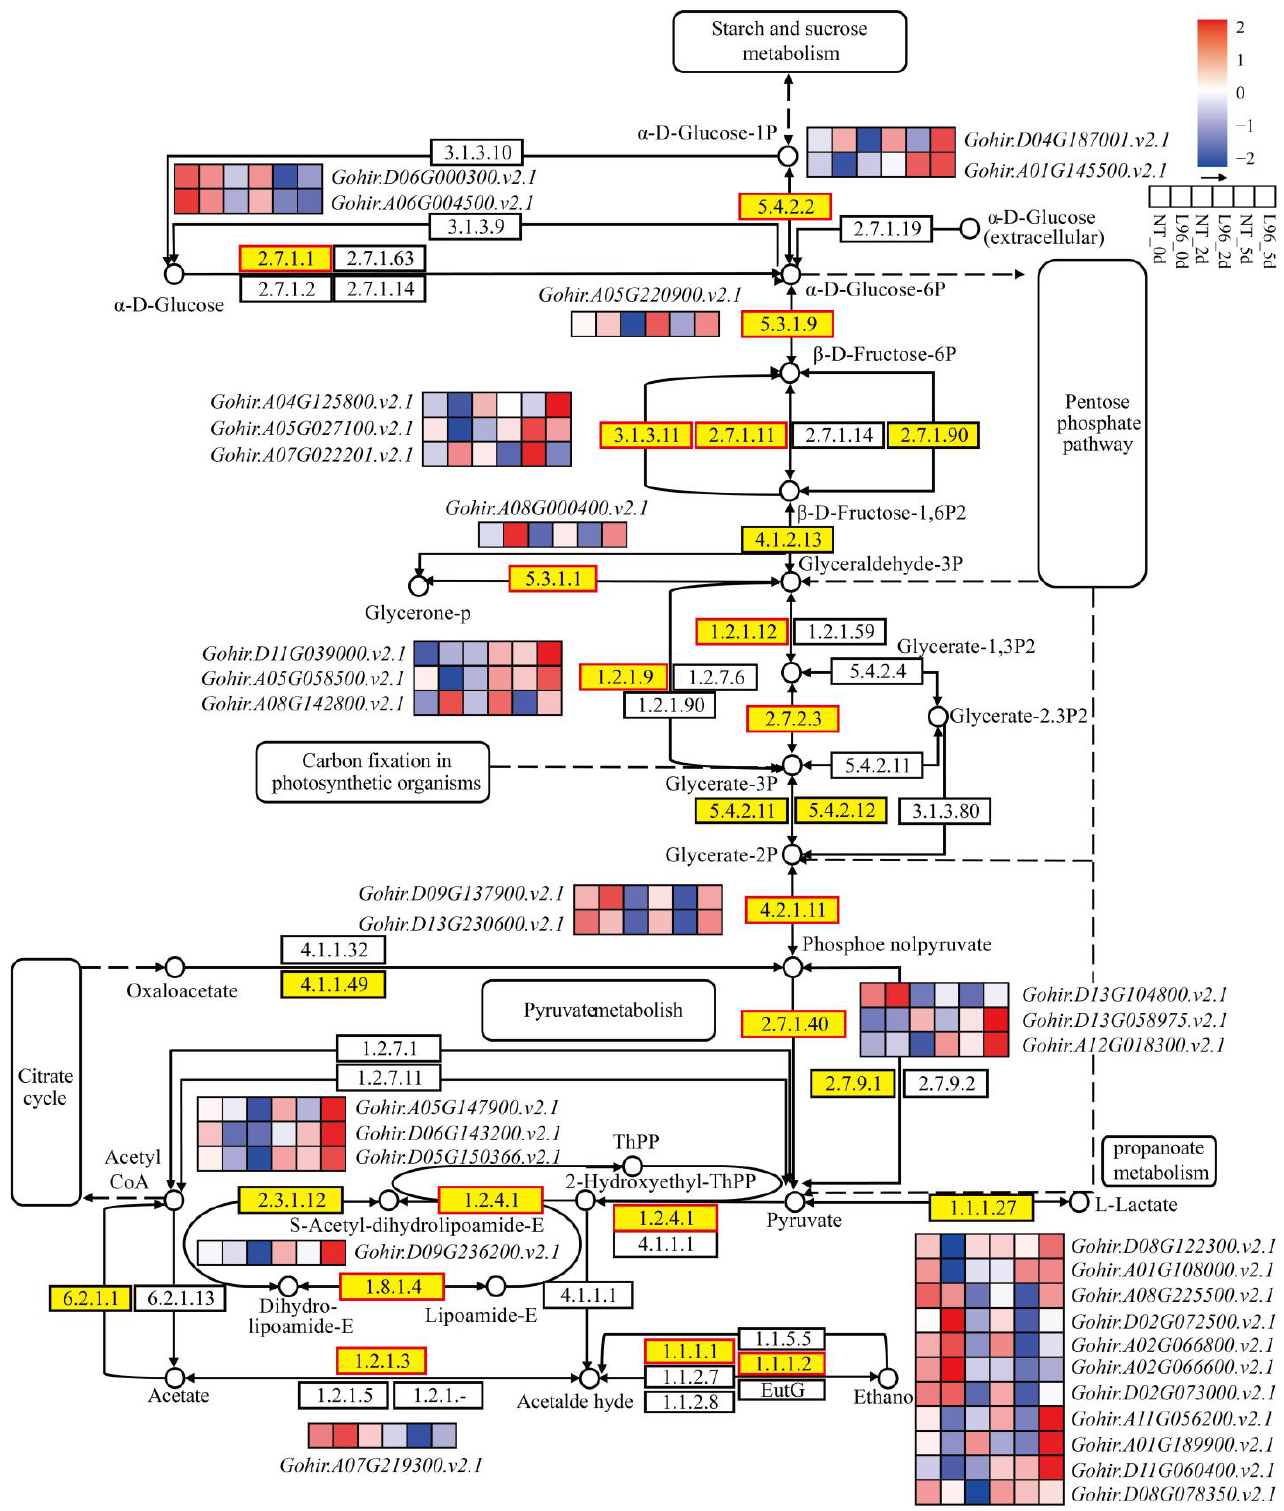
Figure 7. Carbohydrate metabolism activated by L96 and NT under salt stress. Heatmap shows FPKM values in each treatment, normalized using